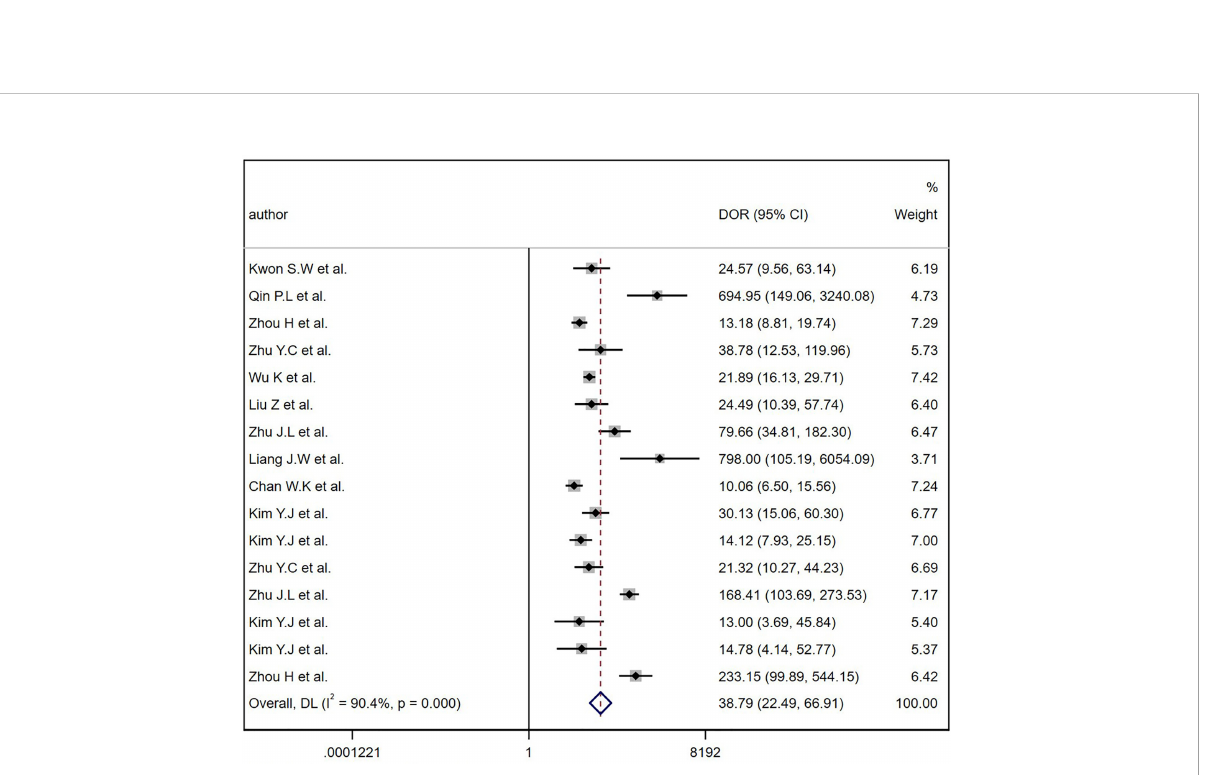
FIGURE 4 The diagnostic odds ratios (DOR) for diagnostic thyroid nodules. Horizontal lines illustrate 95% con fi dence intervals of the individual